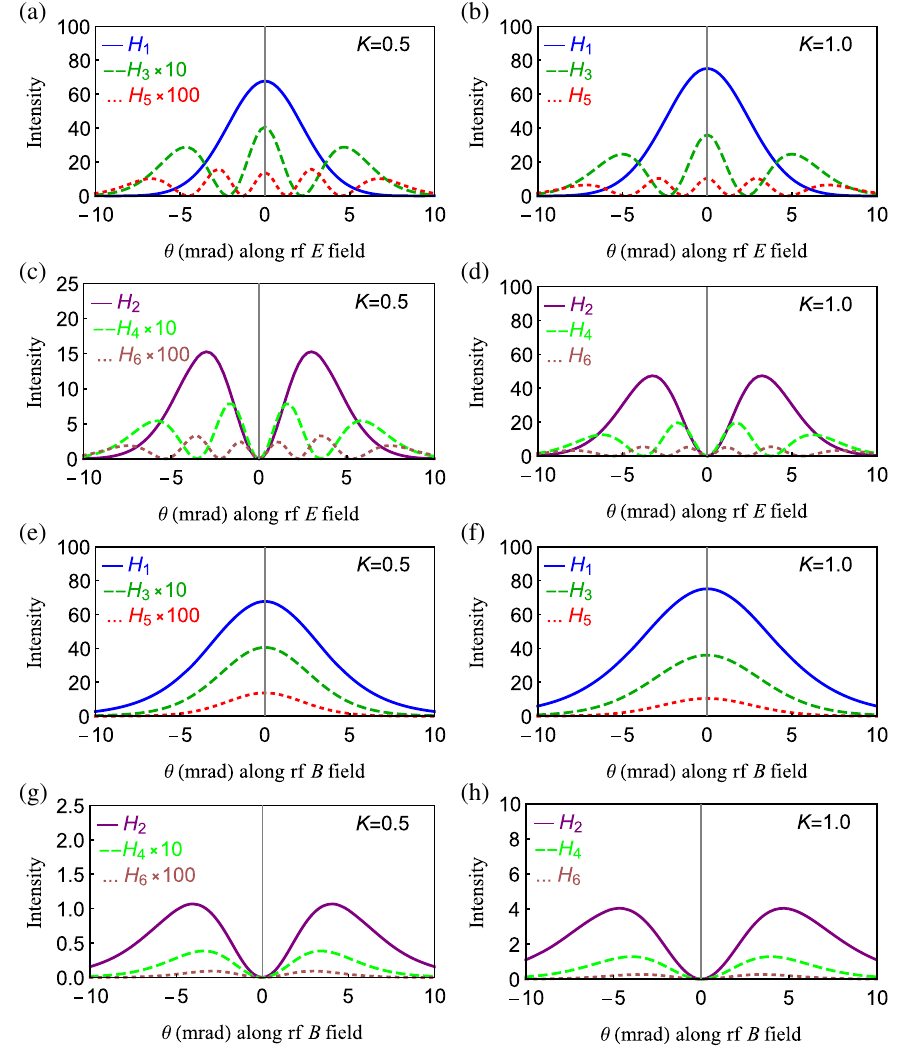
FIG. 3. Linear polarization: For a single electron the intensity (in units of 10 − 12 W m 2 = λ 4 u ) at a distance of 100 λ u of the first three odd and even harmonics vs the off-axis angle θ in a far-field transverse plane. The electron energy is 60